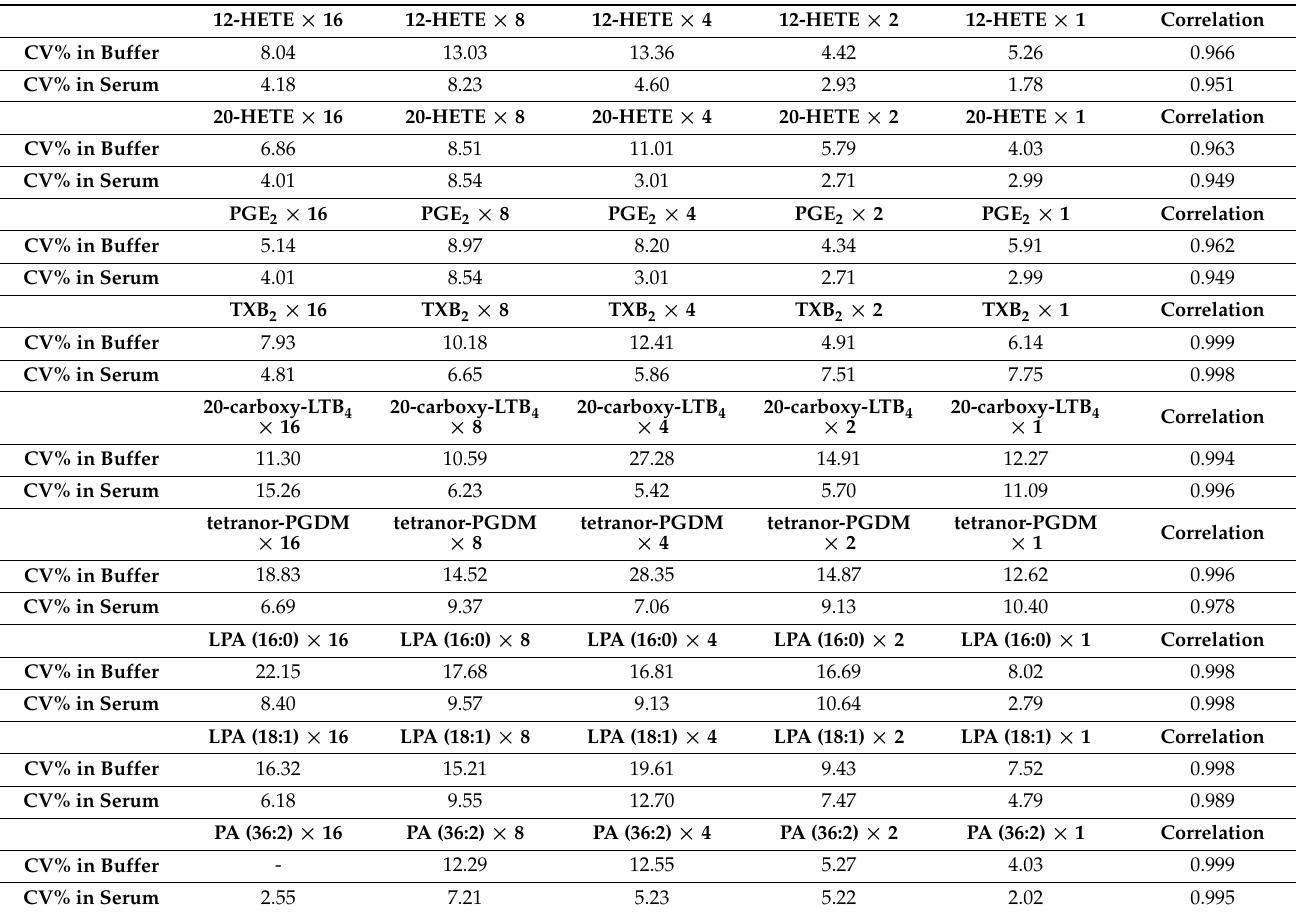
Table 1. Reproducibility of peak area obtained by tandem mass tag (TMT) derivatization methodology in different concentrations of standard